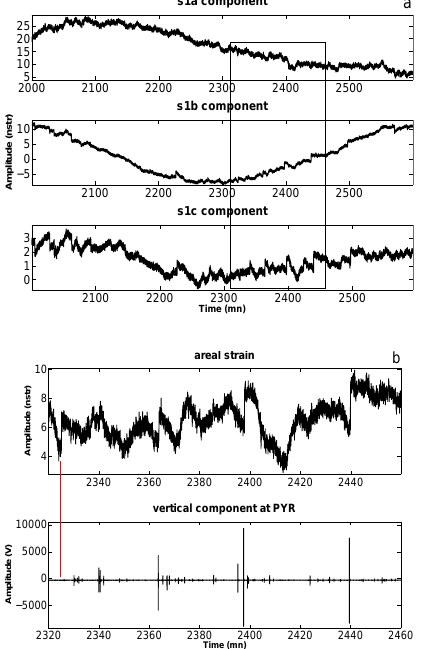
Figure 16. (a) 10 hours of residual strain signal at MOK during day 36, 2011 (5 February). The strain gauges are exhibiting some extensional or compressional steps with amplitude around 1-3 nstr. (b) 2.5 hours of comparison between the areal strain and the vertical velocity component at Pyrgos (PYR) during day 36 (black square, figure (a)). The strain steps seem to be associated to the strongest seismic events during the crisis (figure 1). One of them (around 2325 mn, red line) is unrelated to any relevant seismic wave.